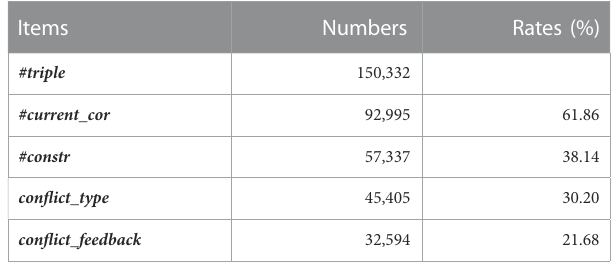
TABLE 2 Negative constraints of nationality in